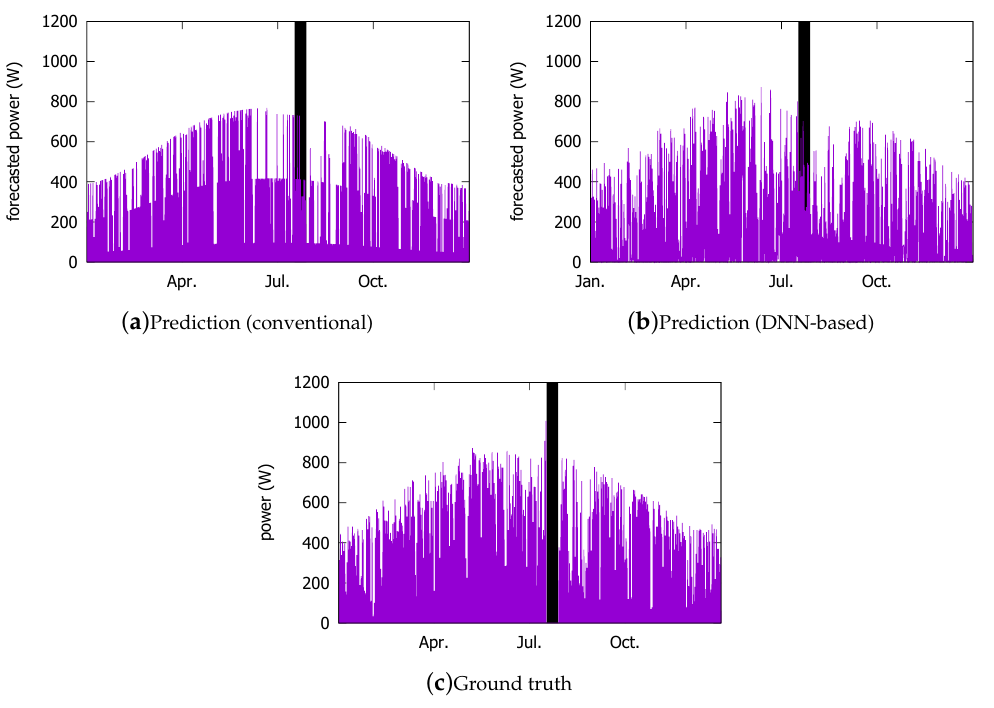
Figure 14. Visual comparison: ( a ) forecast from the current system; ( b ) DNN forecast (for test entries); ( c ) ground